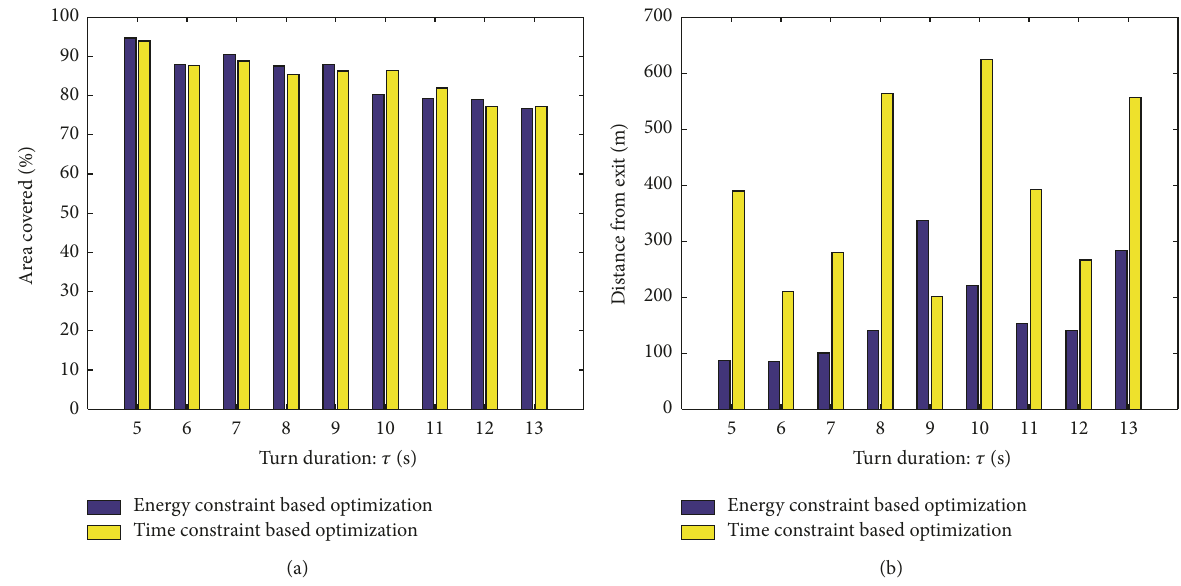
Figure 14: Algorithm performance with decision capability and energy optimization for a range of turn rates: (a) coverage of search region and (b) distance from the desired exit state.